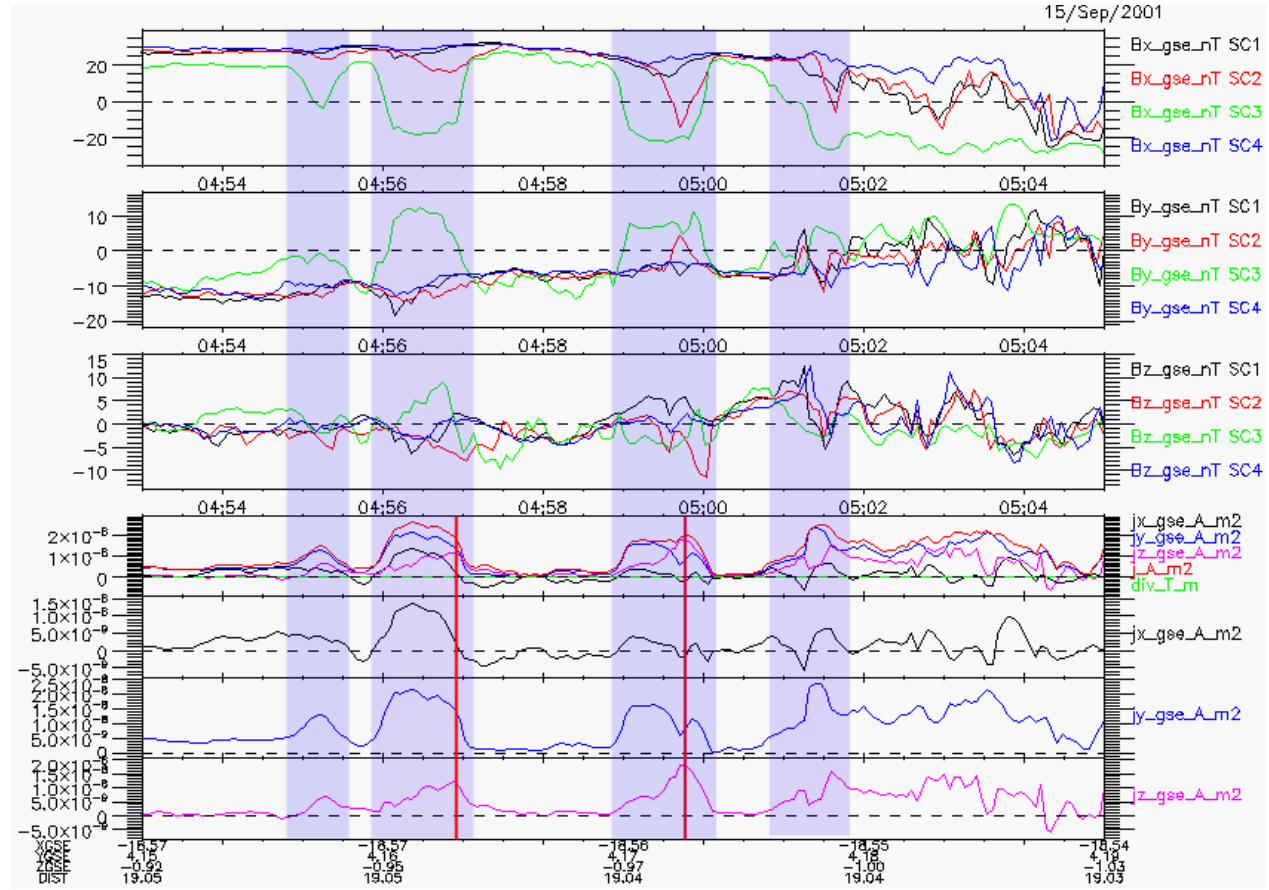
Fig. 10. Components of magnetic field for four satellites and the current density. Four large-amplitude magnetic variations due to flapping motion are labeled by the